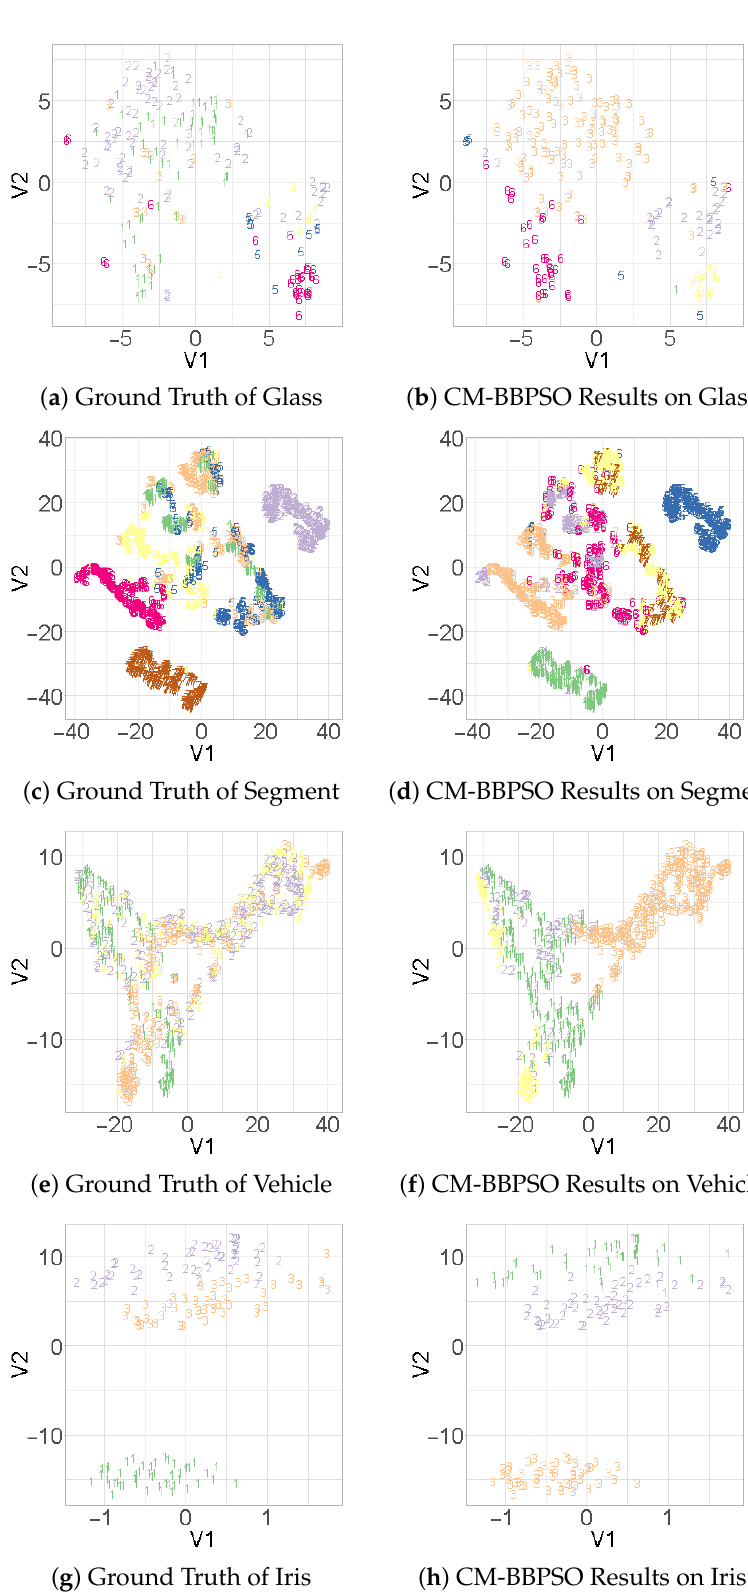
Figure 2. T-SNE biplots of other datasets with overlapping clusters and of Iris. ( a , c , e , g ) Ground Truth for Glass, Segment, Vehicle and Iris respectively and their corresponding CM-BBPSO results in ( b , d , f , h